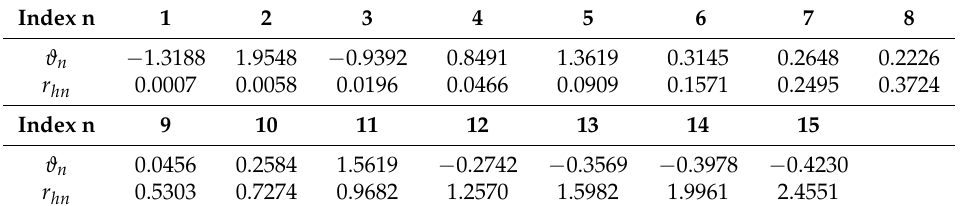
Figure 5. The rate-dependent hysteresis loops of the DEAP actuator. Table 1. The identified weighting vectors of the Prandtl-Ishlinskii (PI) model.